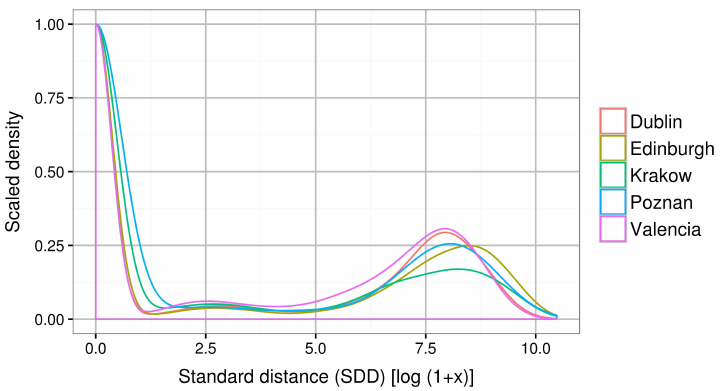
Figure 2. Standard distance characteristics of Twitter users in selected cities. Based on D1 dataset—see explanation in text.